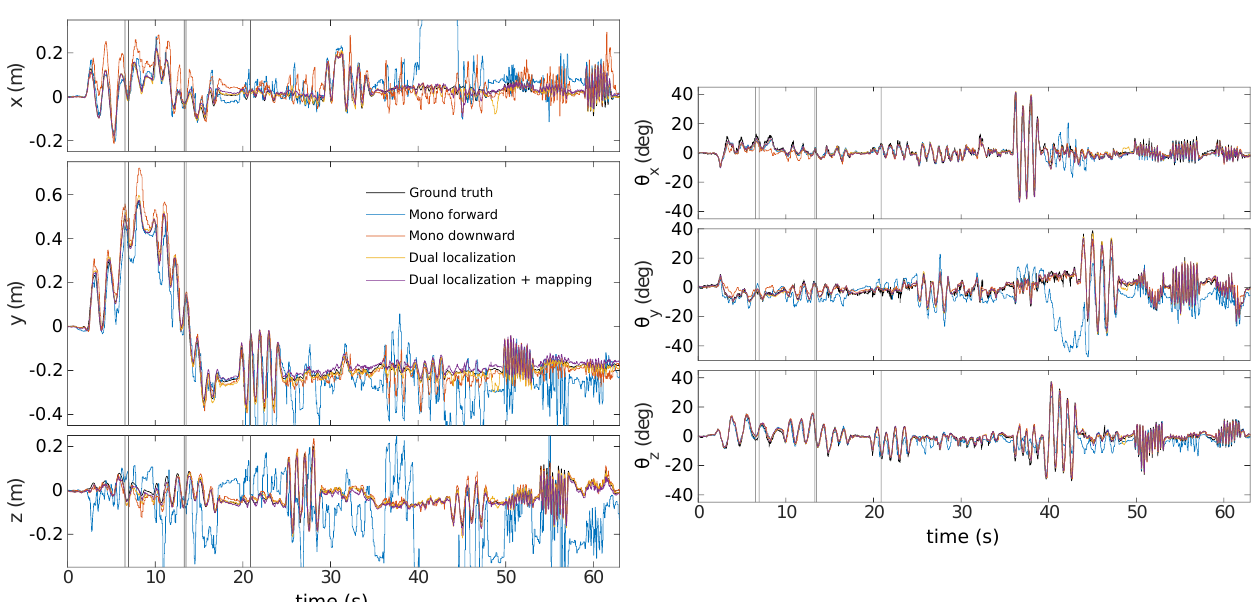
Figure 15. Pose estimates generated by ESPEE, the blue is the sensor in the forward direction, the red is the sensor in the downward direction, the yellow is both sensors with the planar scene assumption, the purple is with the EMVS mapping and in black ground truth generated by the Vicon motion capture system. Vertical lines in grey are the mapping updates during the Dual-sensor localization and mapping experiment.